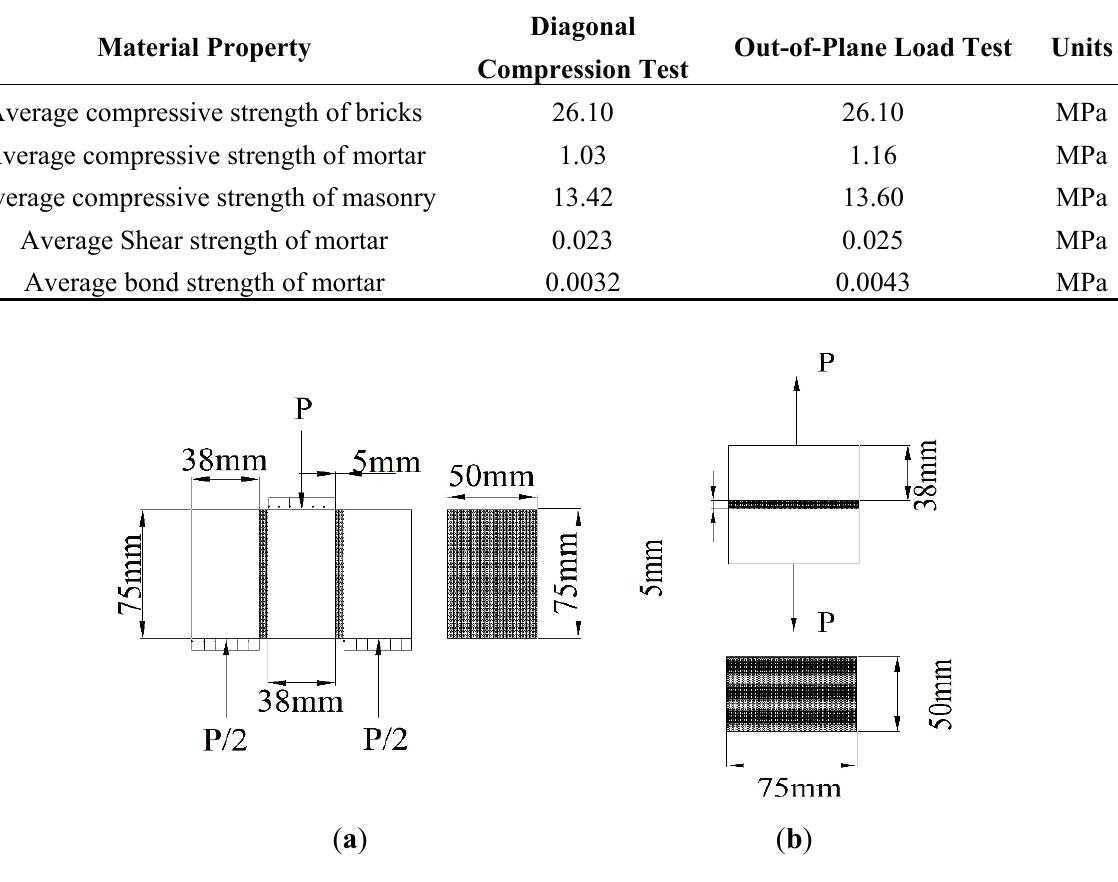
Figure 17. Test setup for masonry ( a ) shear test and ( b ) bond